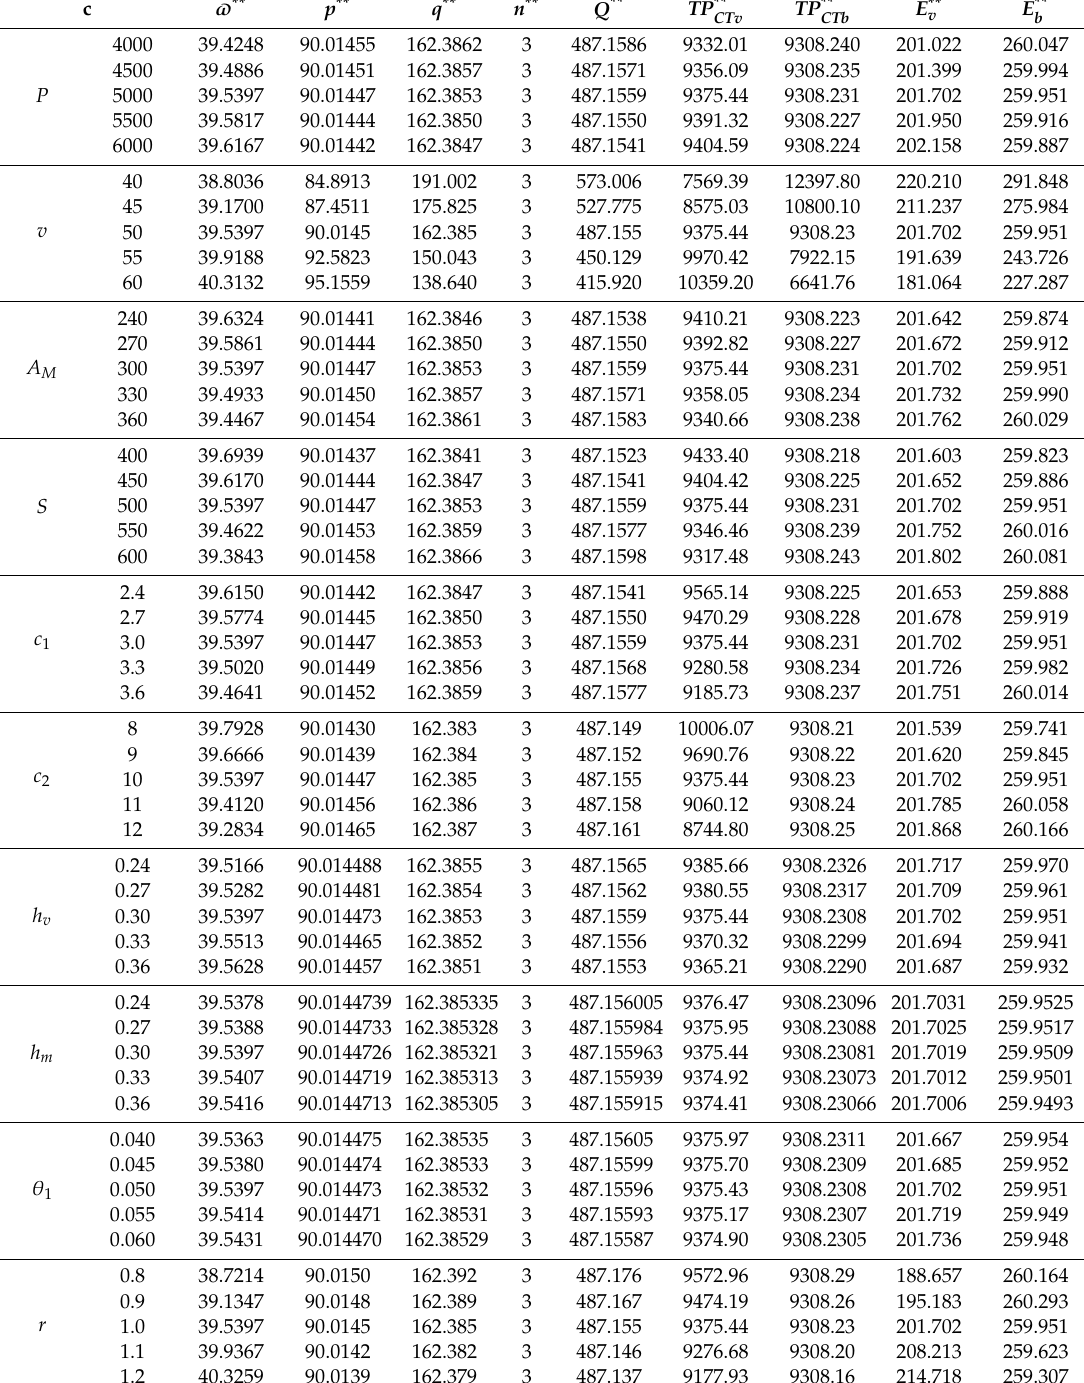
Table 5. Sensitivity analysis for the manufacturer’s parameters in Example